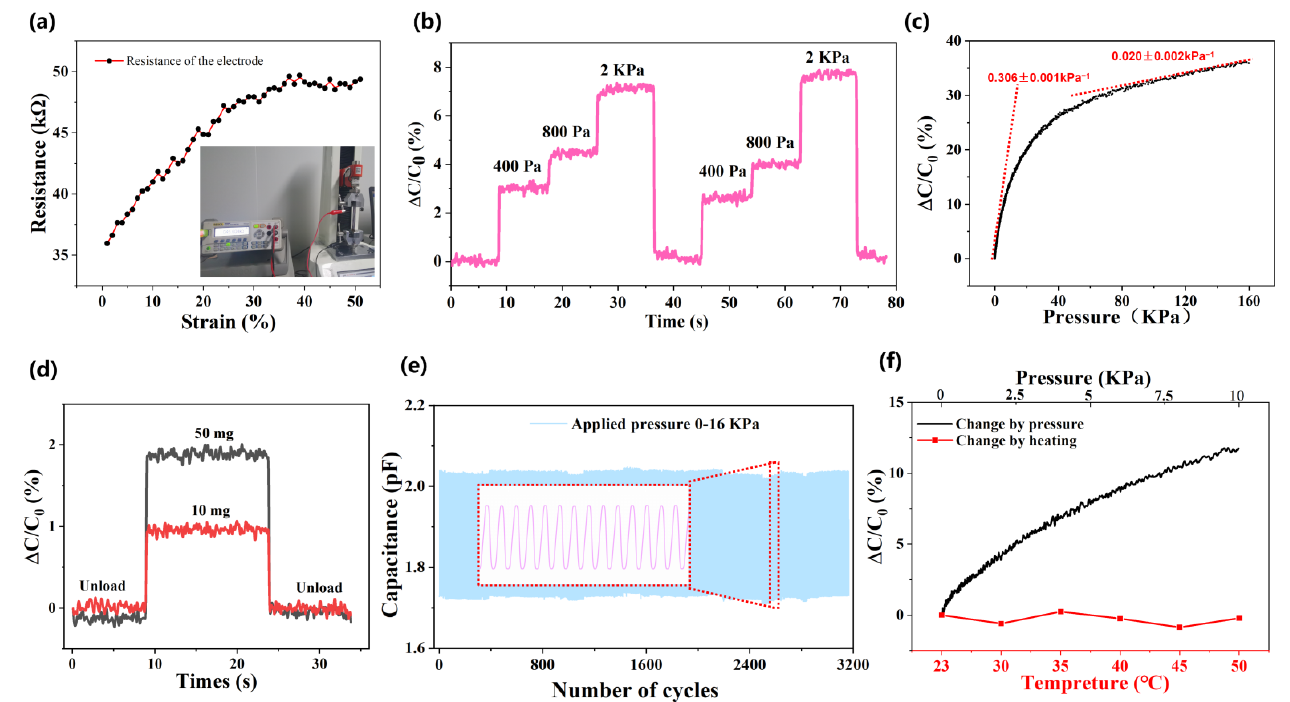
Figure 3. Fundamental performance test of the soft omnidirectional tactile sensor. ( a ) The resistance stability of the coated electrodes during a 50% tension, with the measuring data point (black point) and fitting curve (red curve). ( b ) The dynamic capacitance response of the sensor under repeated various pressures (400, 800, 2000 Pa). ( c ) The capacitance response curve of the flexible pressure sensor under continuous pressure (0~160 kPa). ( d ) The optimized devices response of micro pressures of 50 mg and 10 mg. ( e ) Long-term durability test (over 3200 cycles) of the flexible pressure sensors at a pressure of 16 kPa. Inset: magnified view of 15 cycles for the late stage of the cycle (around 2400 cycles). ( f ) The stability curve (red broken line) of the flexible pressure sensor with the increasing temperature and the capacitance of the sensor increases gradually with the increase of pressure (black curve).